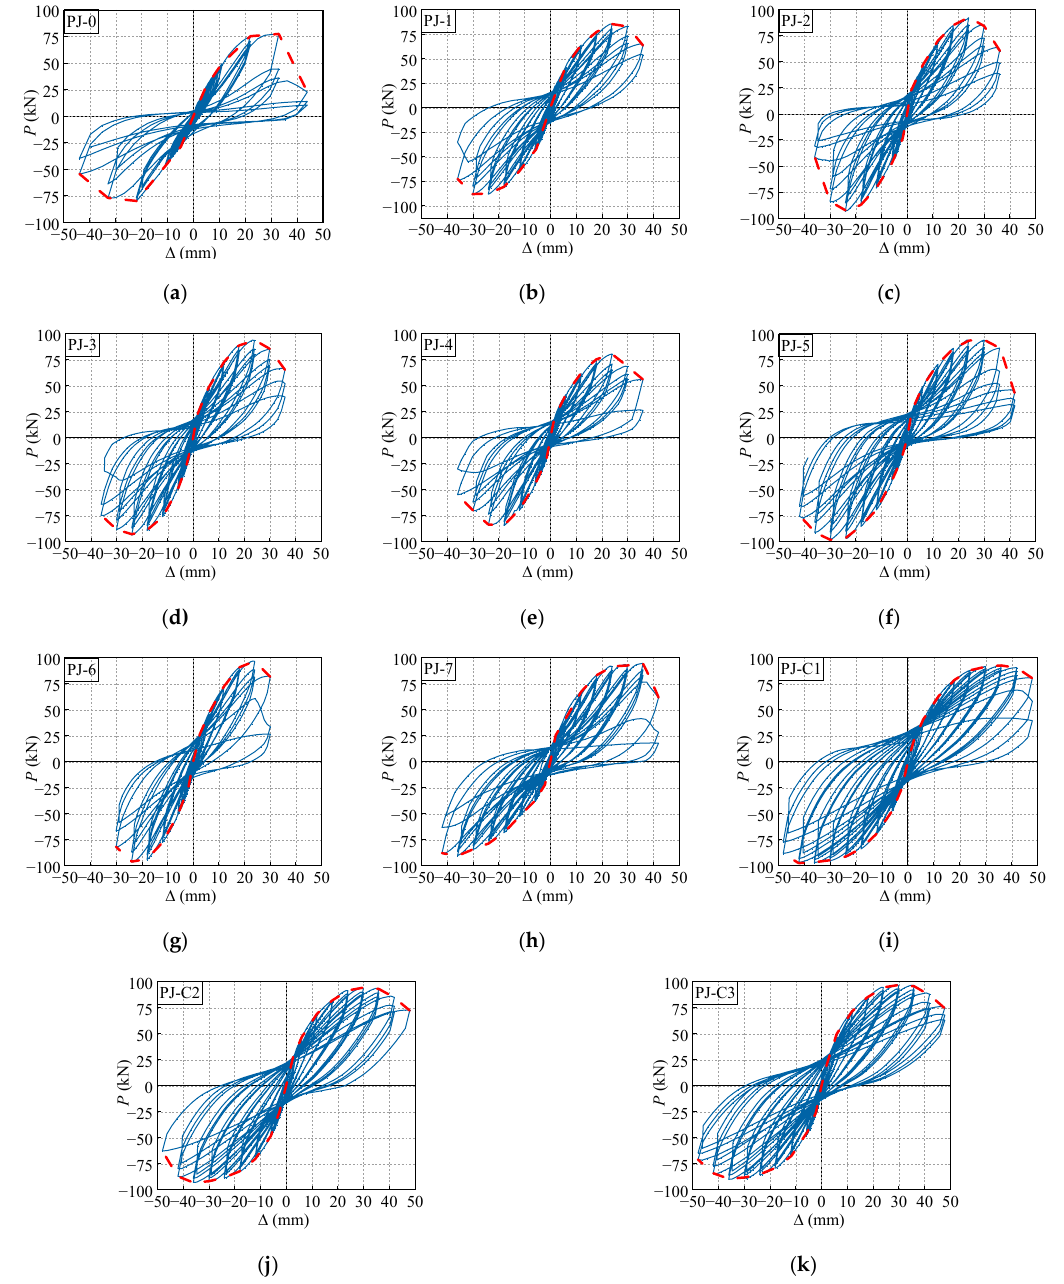
Figure 6. Hysteresis and skeleton curves of the specimens. ( a ) PJ-0. ( b ) PJ-1. ( c ) PJ-2. ( d ) PJ-3. ( e ) PJ-4. ( f ) PJ-5. ( g ) PJ-6. ( h ) PJ-7. ( i ) PJ-C1. ( j ) PJ-C2. ( k )